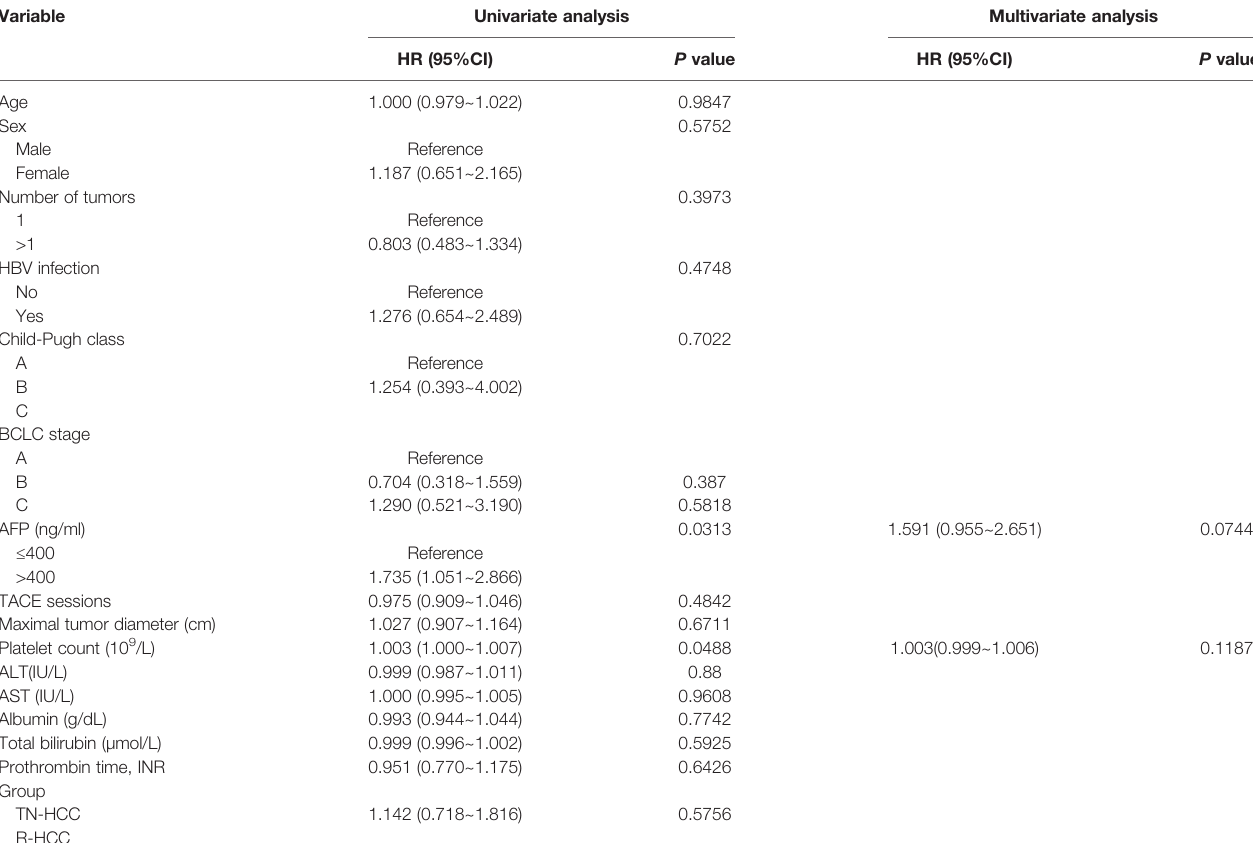
TABLE 3 | Univariate and multivariate analysis of prognostic factors for progression-free survival (PFS) after PSM analysis.